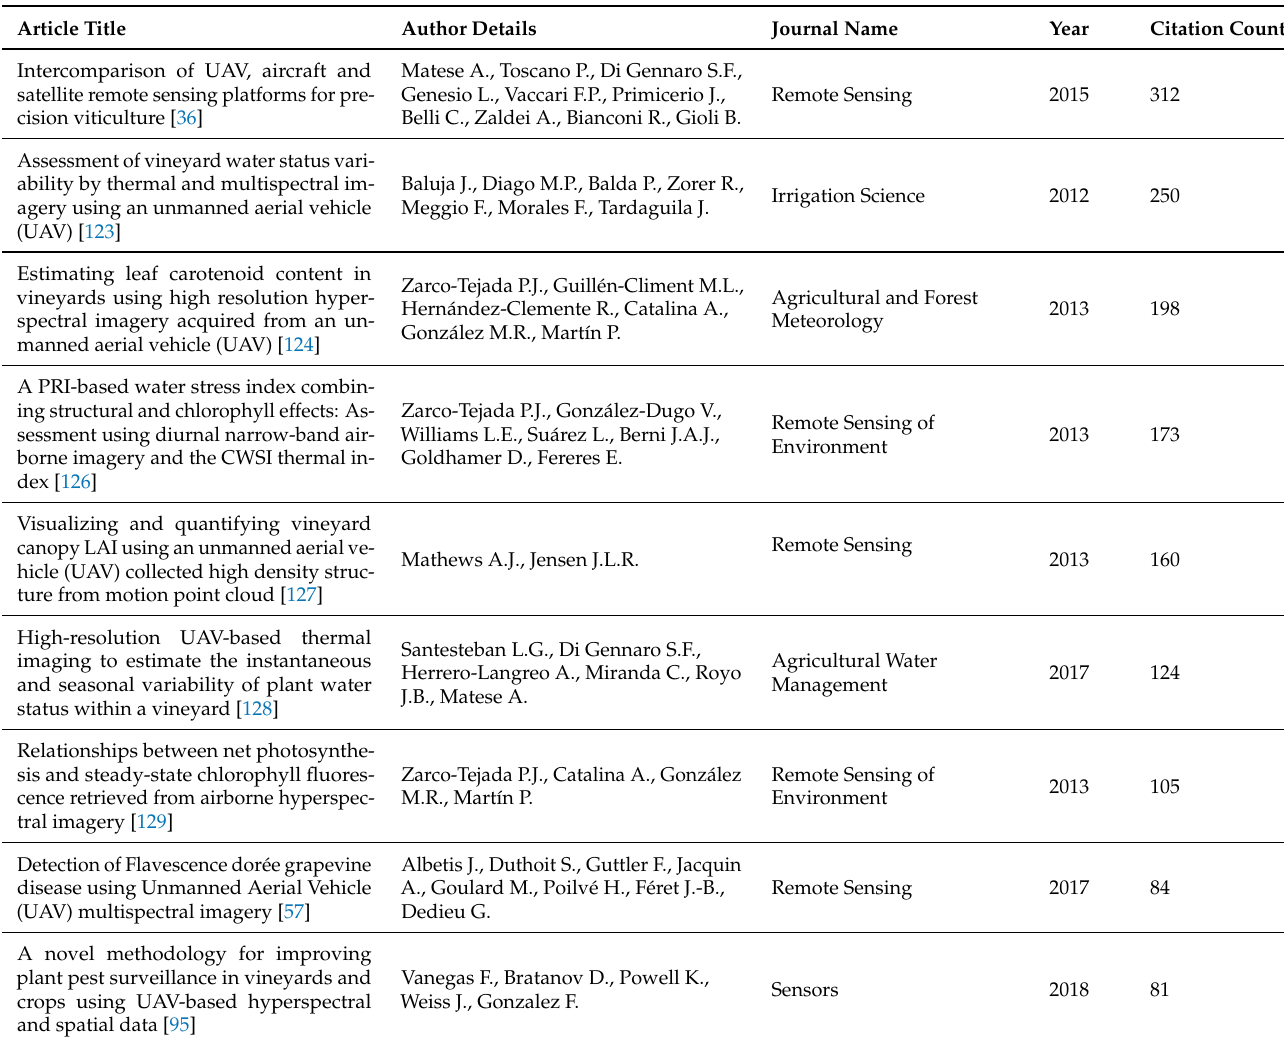
Table 4. Most cited documents on adopting UAV-PV.